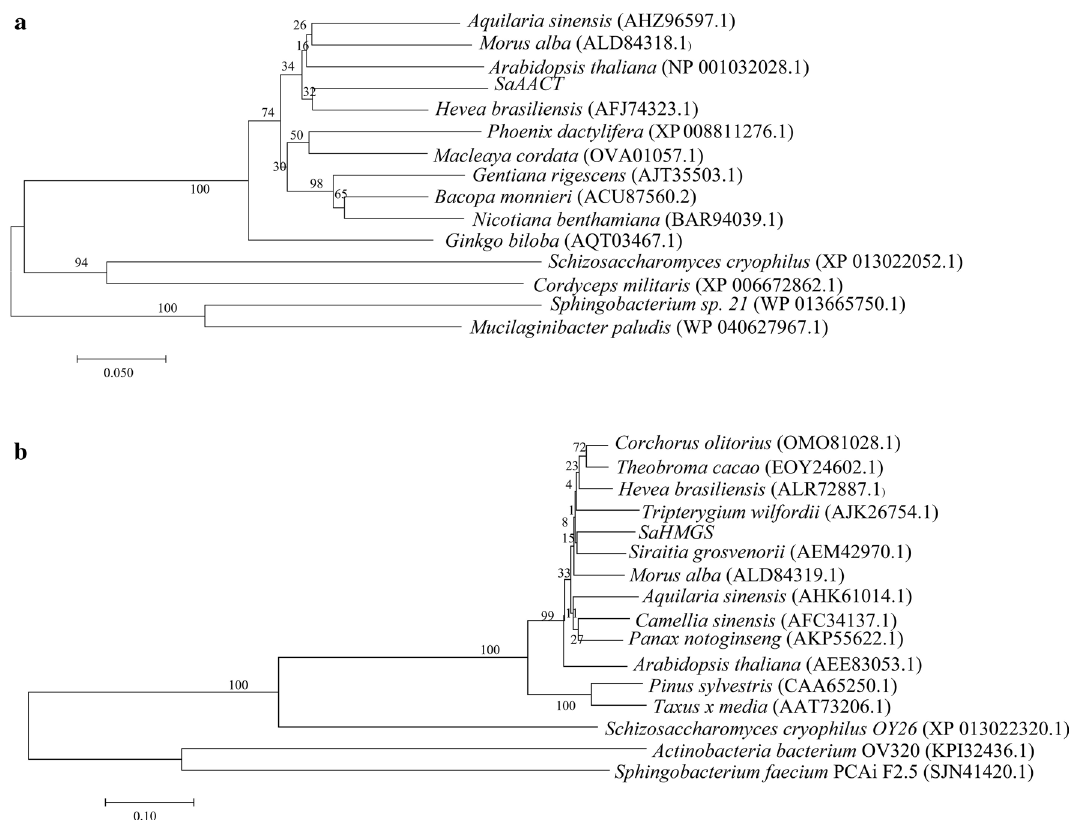
Figure 4. Phylogenetic analysis of target S. album proteins ( a : SaAACT; b :